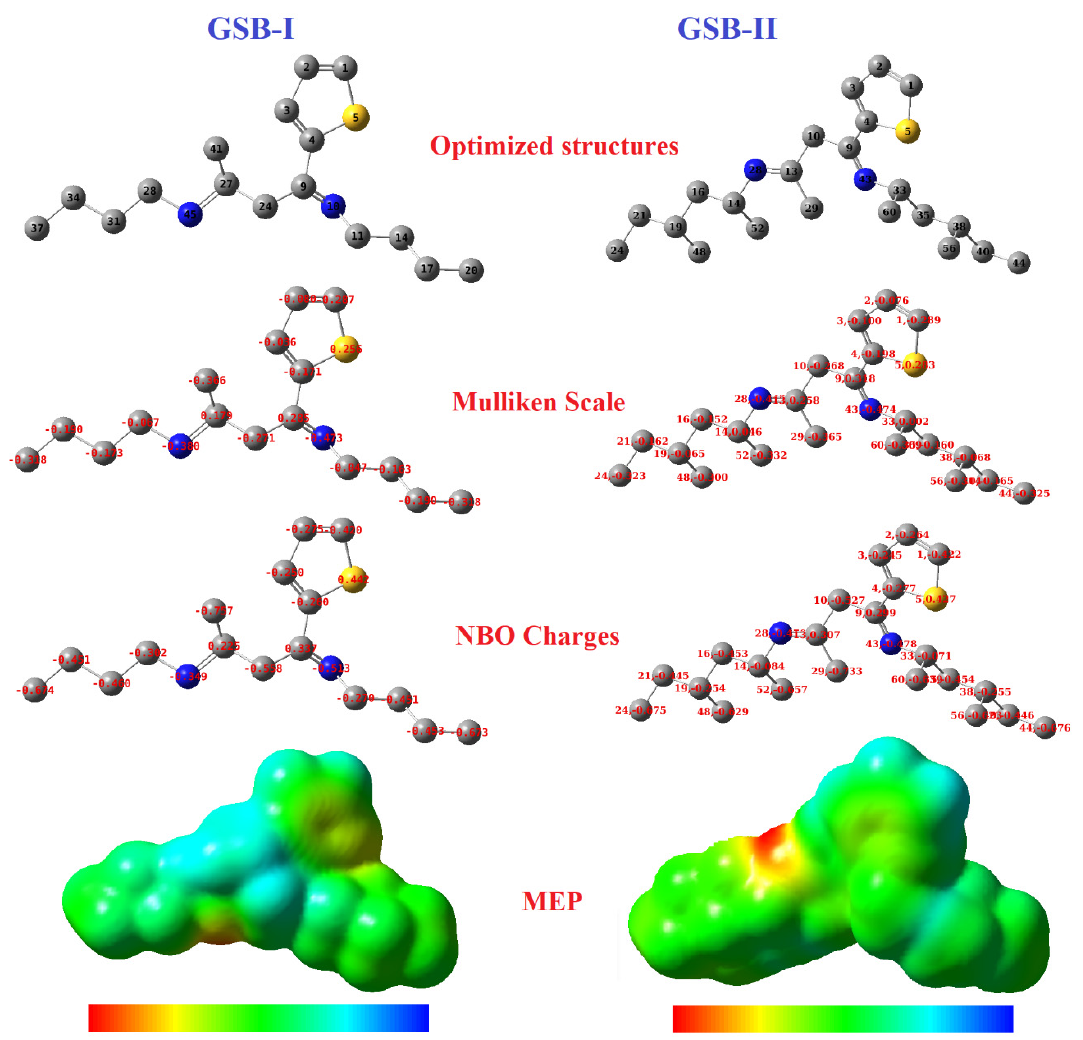
Figure 9. Optimized structures, Mulliken, NBO, and ESP plots of the studied inhibitors.